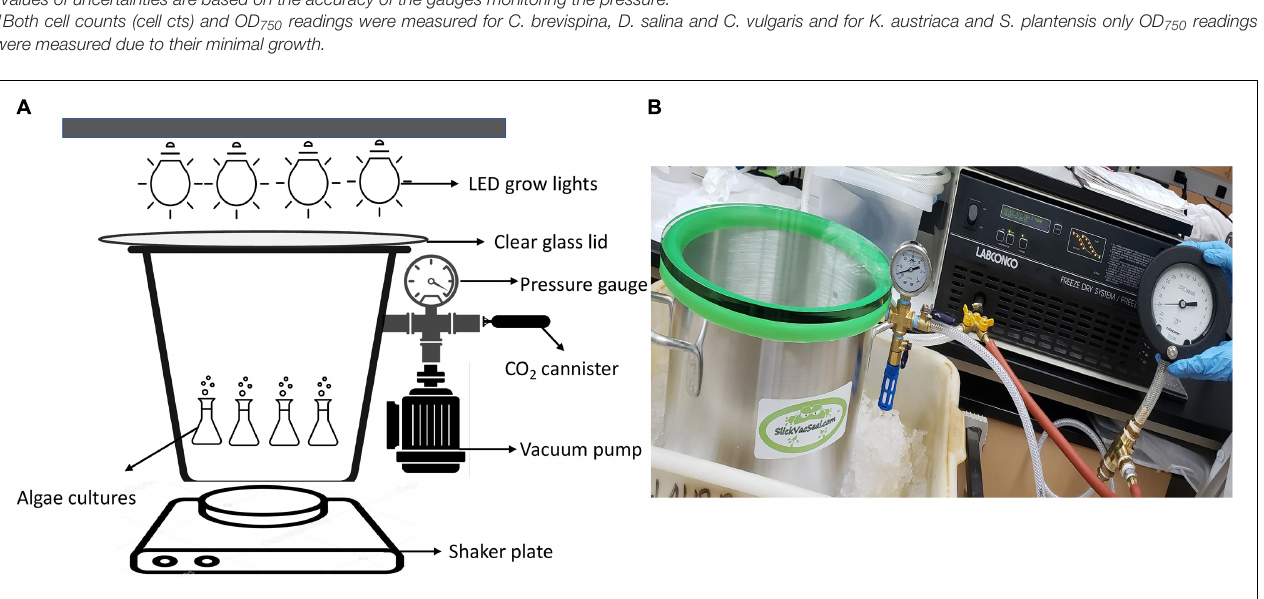
FIGURE 1 | (A) Design of low-pressure growth chamber used for pressures of 330 mbar and below, (B) Photograph of the experimental setup for low-pressure growth experiments of 330 mbar and below using the SlickVacSeal aluminum vacuum